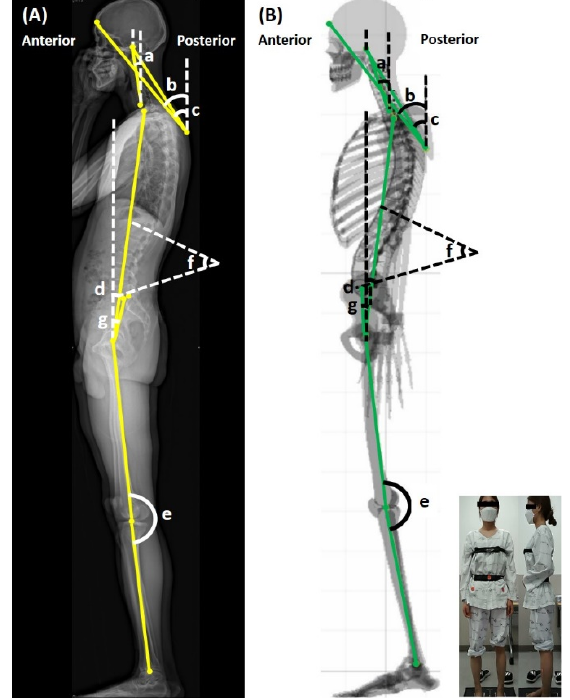
Figure 2. Methods of measuring various sagittal parameters of ( A ) the EOS imaging system and ( B ) PAViR. a, forward head posture (C7-center of auditory canal); b, forward head posture (T4-frontal head); c, forward head posture (T4-center of auditory canal); d, T1 tilt angle; e, knee flexion angle; f, lumbar lordosis angle; g, pelvic tilt angle.